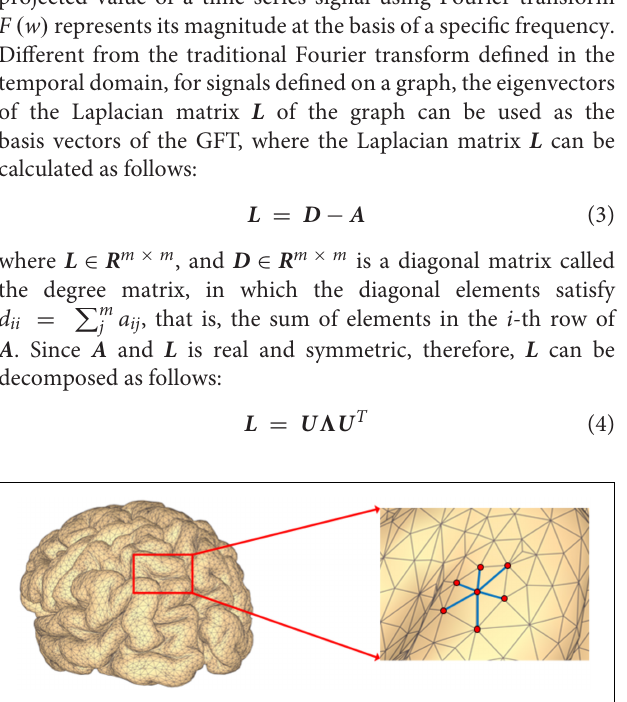
FIGURE 1 | Illustration of brain mesh and brain source extent